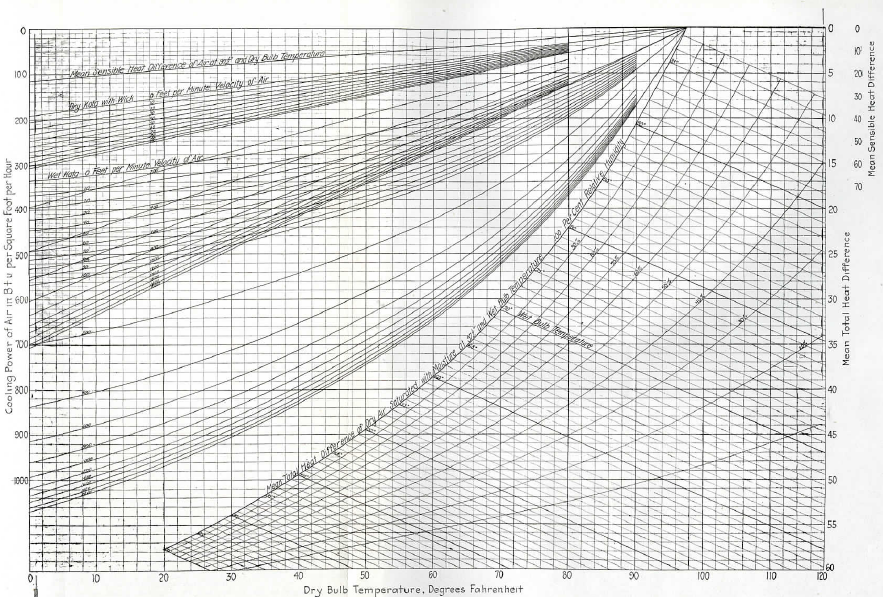
Figure 4. Kata thermometer study from 1922 [13]. Here the abscissa is labeled “Dry bulb temperature, Degrees Fahrenheit”; the ordinate is “Cooling Power of Air in Btu per Square Foot per